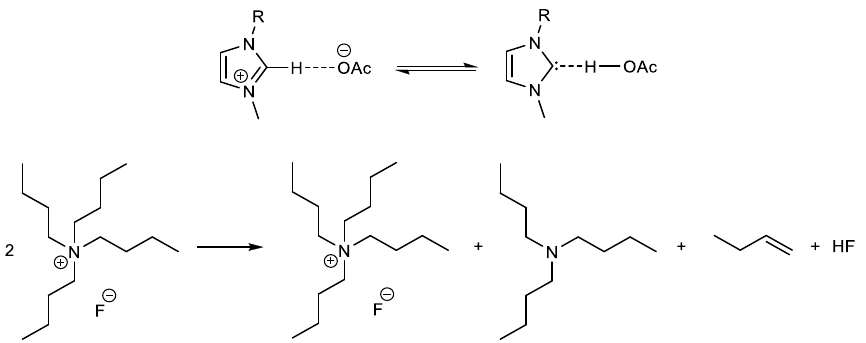
Figure 2. Formation of carbenes ( top ) and Hofmann elimination of quaternary ammonium compounds ( bottom ), redrawn from [21], with permission from Frontiers Media, 2018.